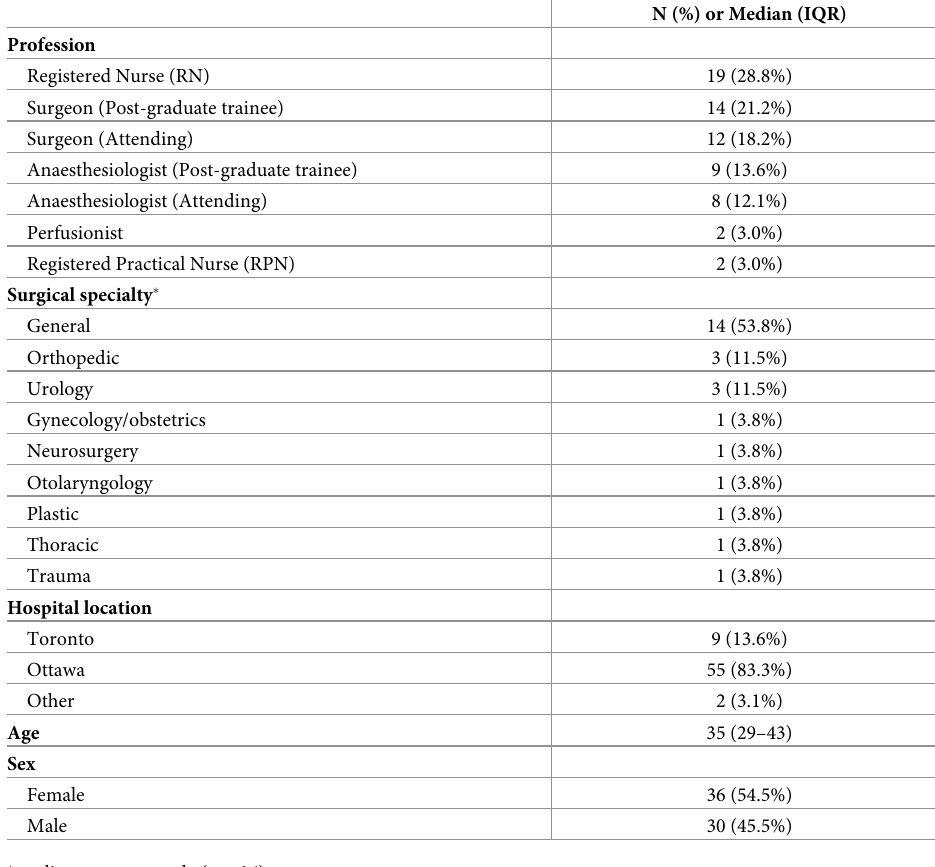
Table 1. Demographics of participants included in study (n =